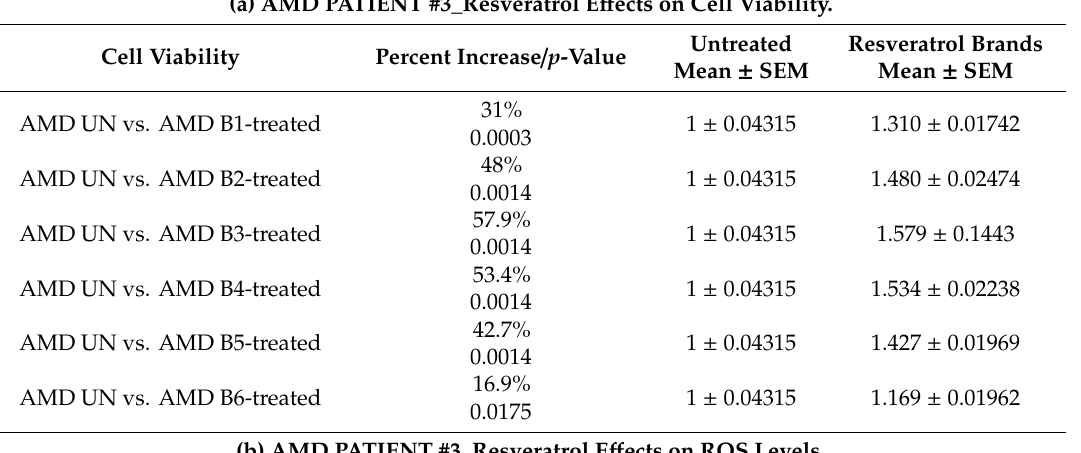
Figure 4. E ff ects of resveratrol formulations on cell viability ( A ) and ROS levels ( B ) in AMD patient #3.